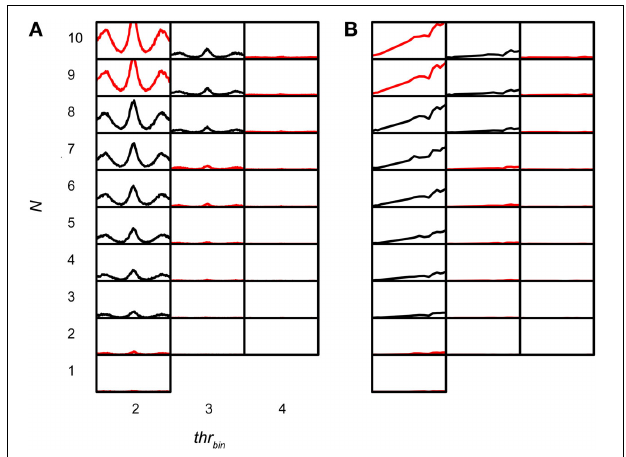
FIGURE 11 | TB simulation output for several N and thr bin . CF 456Hz; SR 89.9Hz; thr mon = 4; cw = 50 µ s. (A) NDFs. The abscissa in each subplot ranges from − 2.94 to 2.94ms. The ordinate in each subplot ranges from 0 to 150Hz. (B) rICFs. The abscissa in each subplot ranges from − 1 to 1. The ordinate in each subplot ranges from 0 to 150Hz. N and thr bin are the same in (A) and (B)